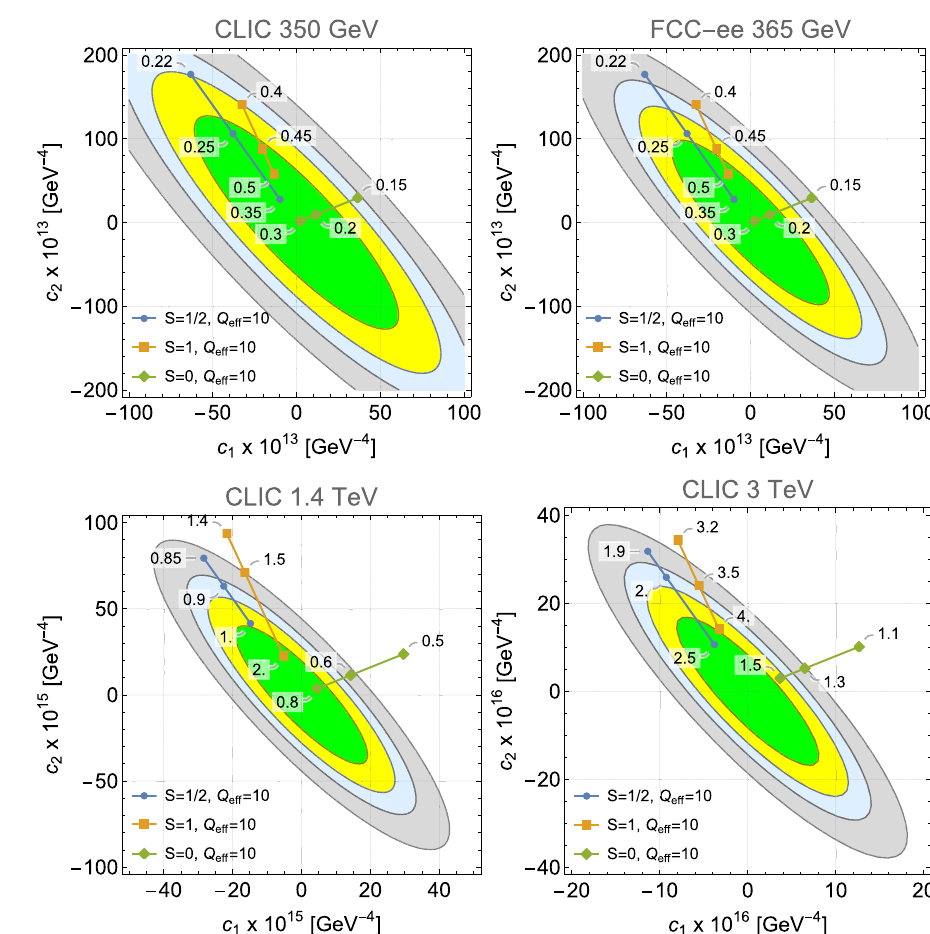
Fig. 5 Contours in the ( c 1 , c 2 ) plane of 1-, 2-, 3-, and 5- σ significance sensitivities of possible measurements with FCC-ee and CLIC at 350 GeV are shown in the upper panels, and those of possible CLIC measurements at centre-of-mass √ s = 1 . 4 and 3 TeV energies are shown in the lower panels. The potential 5- σ discovery region is outside the grey contour, and the potential 95% exclusion reach is outside the yellow contour. Also shown are the lines corresponding to the Heisenberg–Euler [1] contributions of heavy spin 0, − 1 / 2 and − 1 beyond-the- Standard-Model particles in blue, orange, and green, respectively, with effective charge Q eff = 10, a value that has been chosen for consistency with the validity of the relevant EFT. The dots are labelled with the masses of the particles in units of